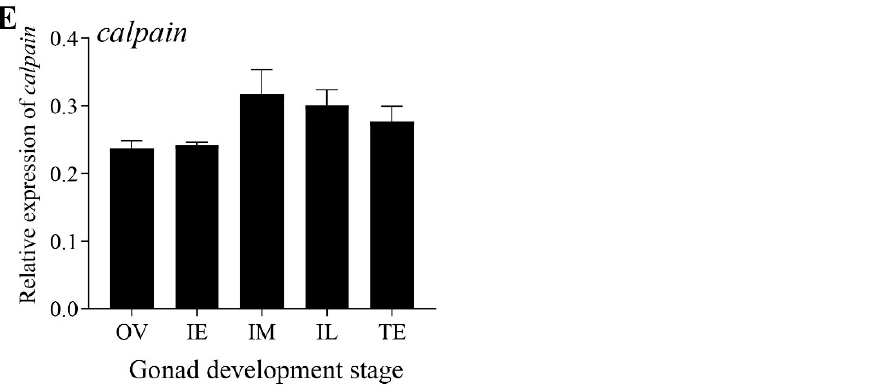
Figure 3. Expression patterns of apoptotic genes related to the three signaling pathways during the gonadal development of Monopterus albus . ( A ), Expression patterns of bax and apaf-1 in the mitochondrial pathway. ( B ), Expression patterns of fadd and tnfr1 in the dead receptor pathway. ( C ), Expression patterns of calpain in the ER pathway. OV, ovary; IE, early intersexual stage gonad; IM, middle intersexual stage gonad; IL, late intersexual stage gonad; TE, testis. The results are presented as the means ± SEMs. Asterisks (*) indicate significant differences between two groups ( p < 0.05).